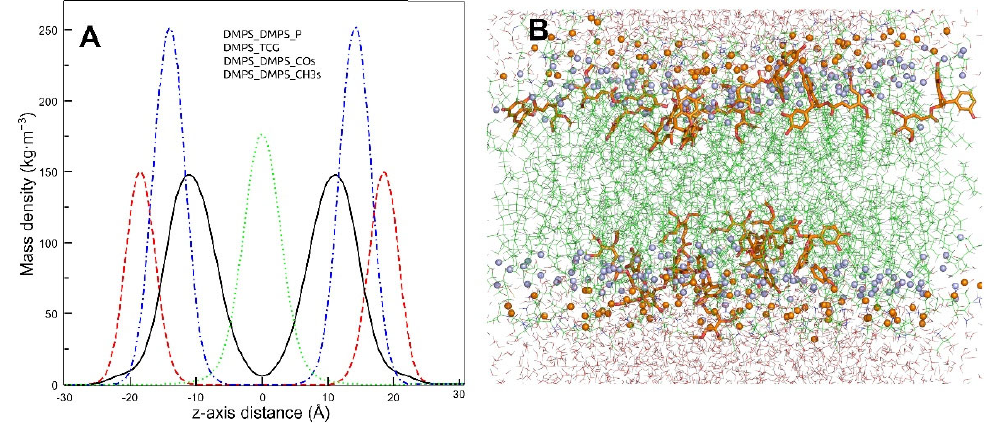
Figure 7. ( A ) Mass density profiles along the z-axis of the simulation box of DMPS–TMBC membrane at 323 K. TMBC molecules in solid line, phosphorus atoms in dashed line, lipid carbonyl groups in dash-dot line, and lipid terminals methyl carbon atoms in dotted line. ( B ) Final snapshot of the simulation box of the DMPS–TMBC membranes. Water molecules are shown in lines, TMBC in sticks, DMPS in lines, lipid carbonyl groups in light spheres, and phosphorous atoms in dark spheres.